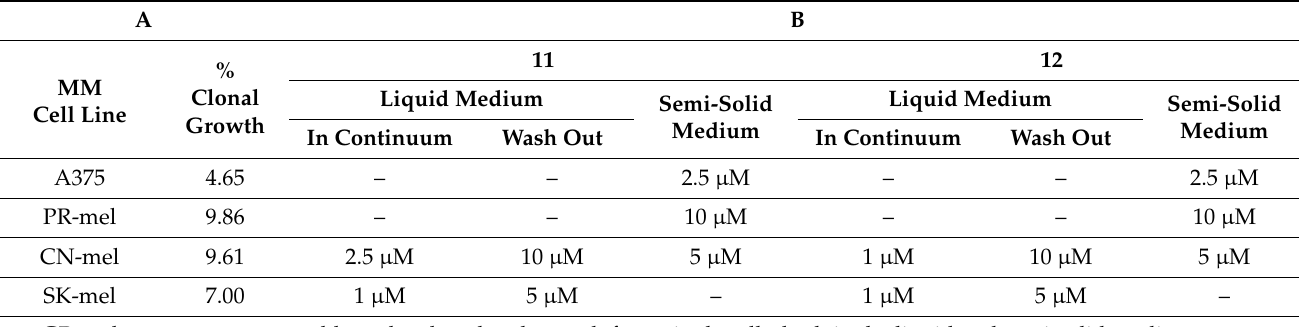
Figure 3. Time dependence. Drug wash-out assays assessed the impact of 11 and 12 time exposures on the cell proliferation of both MM cells and BJ fibroblasts. Cells were incubated with 5 μ M of either 11 ( A ) or 12 ( B ) for the indicated times and then washed and cultured in drug-free medium up to 72 h. Cell proliferation was assessed by MTT assays as described. The results were derived from three different experiments, each done in triplicate, and expressed as the mean percentage of cell growth ± standard deviation. ° p ≤ 0.05, SK cell line vs. BJ; * p ≤ 0.001 , MM cell line vs. BJ. Table 2. Clonal growth inhibition. The table lists ( A ) the tumorigenic capacity of each cell line (% clonal growth), representing the percentage of colonies grown in clonal conditions compared to the number of cells initially seeded, and ( B ) the concentrations of 11 and 12 able to totally inhibit the melanoma cells clonal growth in both the semi-solid and/or liquid media culture